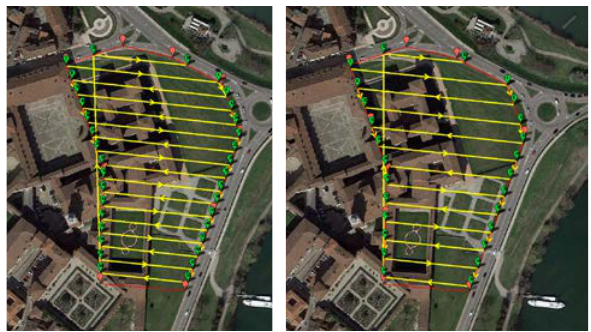
Figure 1. Flight plan of a part of Palazzo Ducale in Mantova by two UAVs (on the left the ultralight Dji Spark), on the right the very light Dji Mavic. Flight plan was carried out by